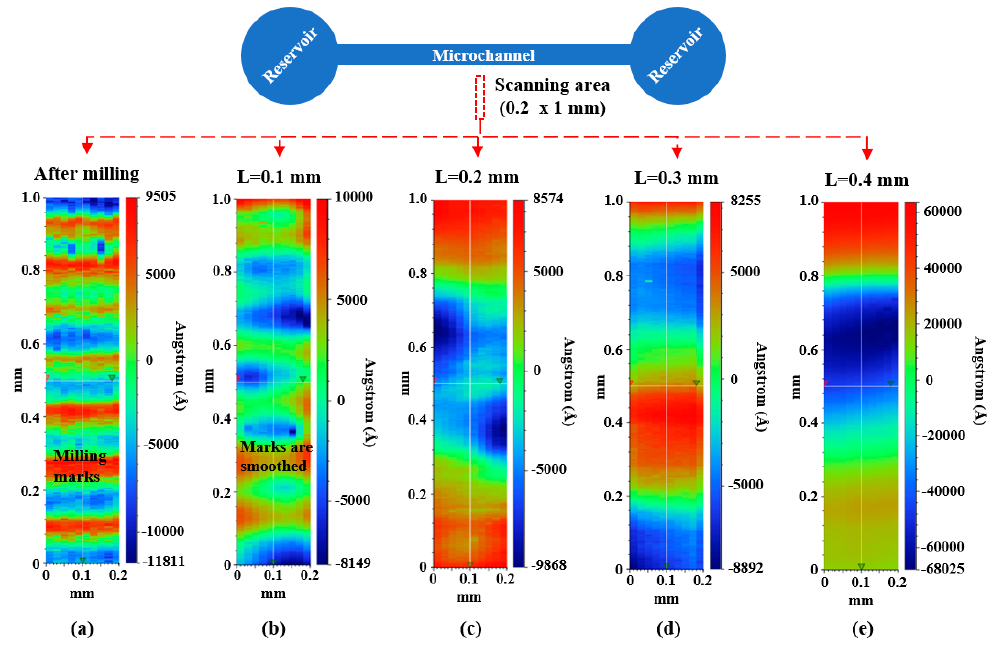
Figure 7. The 3D map of the mechanical polishing micromold analyzed by a surface profilometer. ( a ) After milling and polished with wool felt bit with pressing length ( b ) L = 0.1, ( c ) L = 0.2, ( d ) L = 0.3, and ( e ) L = 0.4.